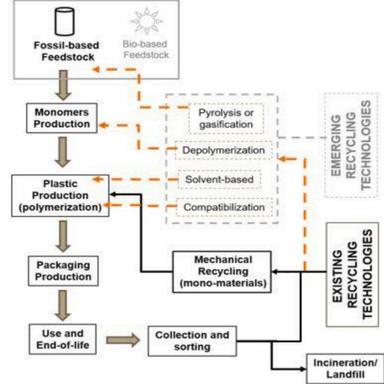
Plastic packaging value chain and its recycling routes, including existing and emergent technologies. The production of plastic materials starts with raw materials from fossil (most of the current production) or bio-based feedstocks. Then, different processes are used to produce distinct types of packaging. After its use and end-of-life, packaging materials are sorted according to the local infra-structure. If recycled, the usual recycling route for monomaterial plastic packaging is through mechanical recyc